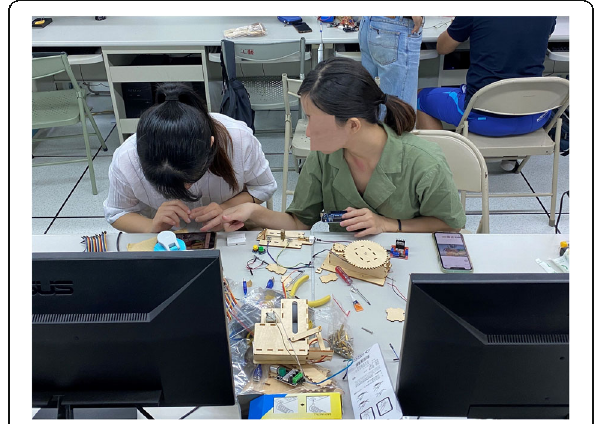
Fig. 3 Teachers discussed with each other during the PDP Fig. 4 Electronic circuit design and microcontroller systems